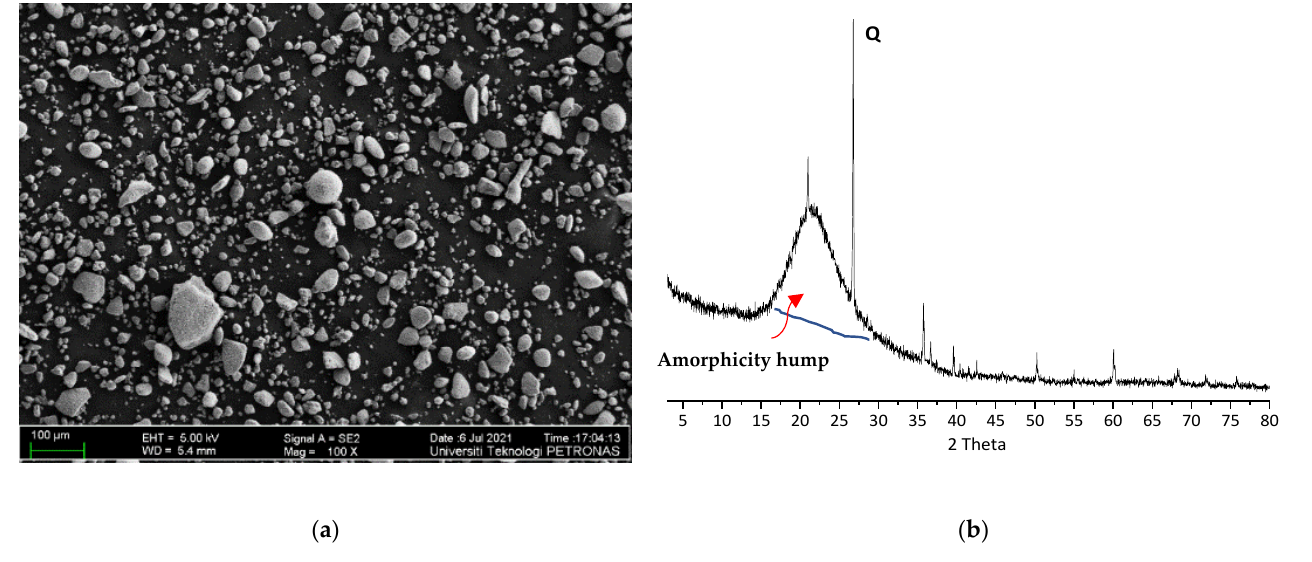
Figure 2. ( a ) FESEM of Silica Fume; ( b ) XRD of Silica Fume (Note. Q: Quartz).